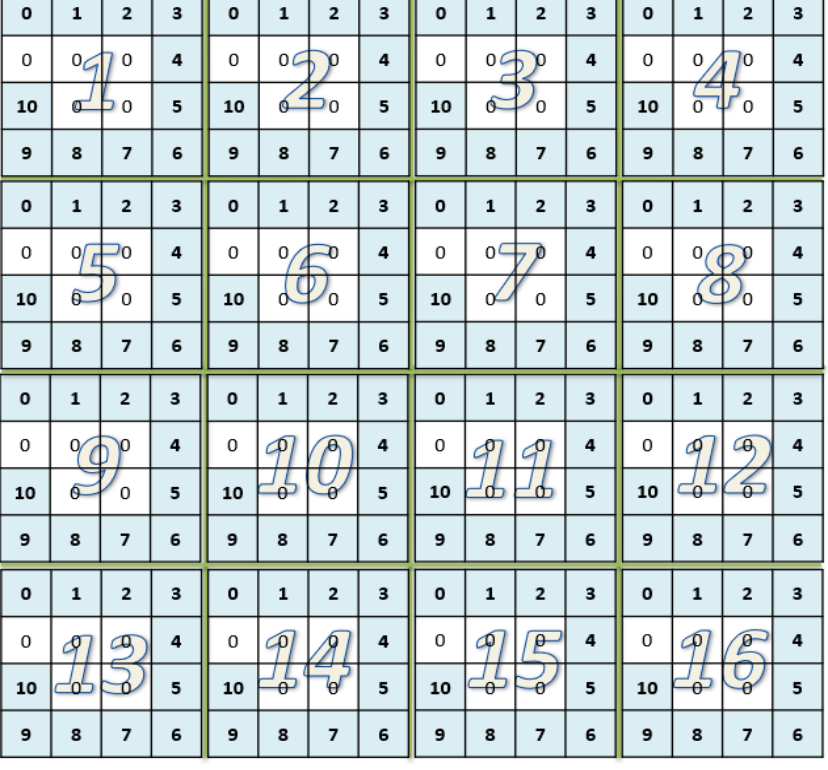
Figure 4. The 16 4 × 4 data grids, to splice a Mosaic data structure, in which 16 such data grids were, sequentially, arranged one after another in the data pattern, to keep the temporal characteristics of the original data.